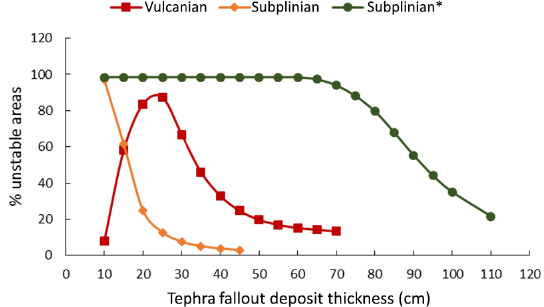
Figure 10. Percentage of unstable area for the NW and S lahar source areas simulated with TRIGRS for tephra fallout deposit thicknesses of 0.1–1.1m and a rainfall intensity of 6.4mmh − 1 with a duration of 5h, as well as parameters for the following: Vulcanian tephra fallout deposits (red squares); subplinian tephra fallout deposits with K s = 1 × 10 − 2 ms − 1 (value from the litera- ture; orange diamonds); and subplinian tephra fallout deposits with K s = 6 . 8 × 10 − 4 ms − 1 (value measured in the field; green